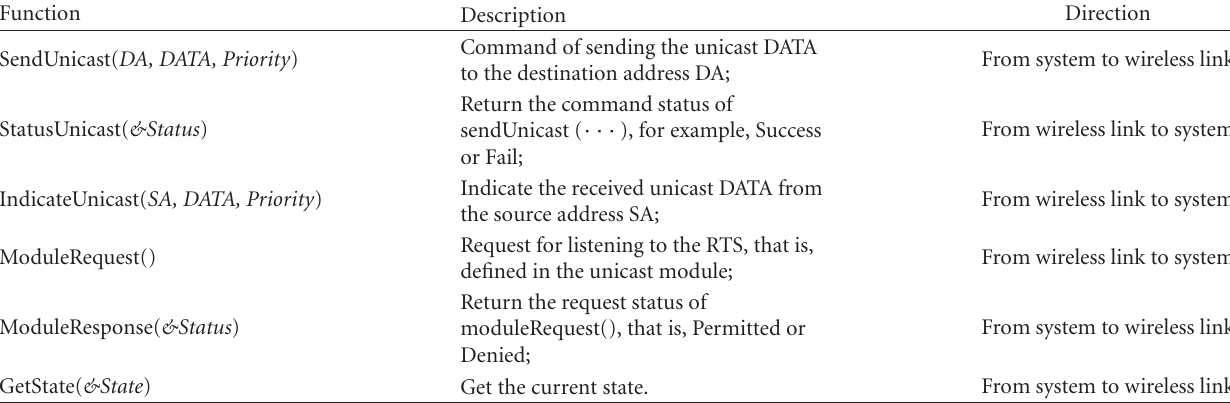
Table 1: Exemplary primitive functions related to the unicast